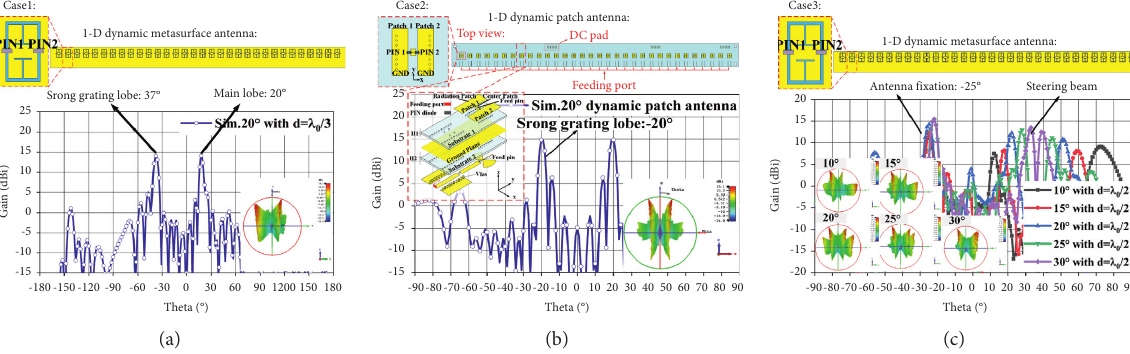
Figure 1: The grating lobe and beam fixation problems simulated by CST. (a) Grating lobe problem for the dynamic metasurface antenna � 10mm; and λ � 6 . 5mm). (b) Grating lobe problem for the dynamic patch antenna (where M � 32 and element spacing (where M � 32; λ g 0 d � λ /2). (c) Beam fixation problem for dynamic metasurface antennas (where M � 32; λ 0